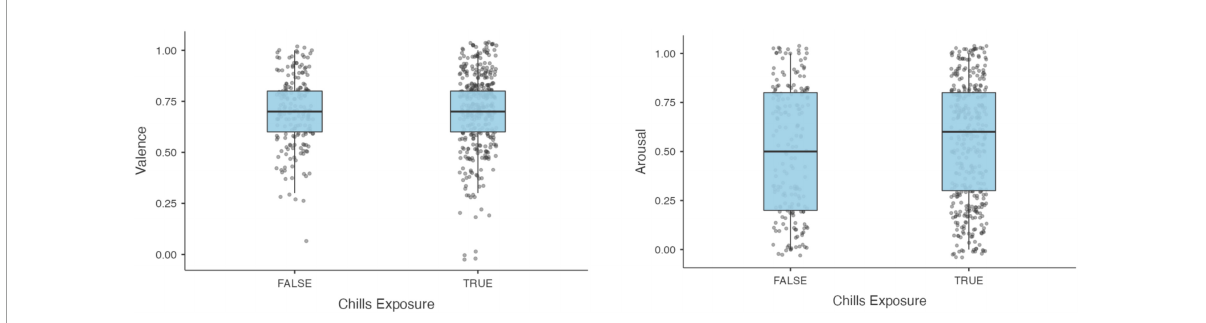
FIGURE1 Arousal and valence ratings prior to exposure to the stimulus are normalized across participants, independently of whether they reported chills. Hence, prior valence and arousal do not seem to influence the probability of participants to experience chills.